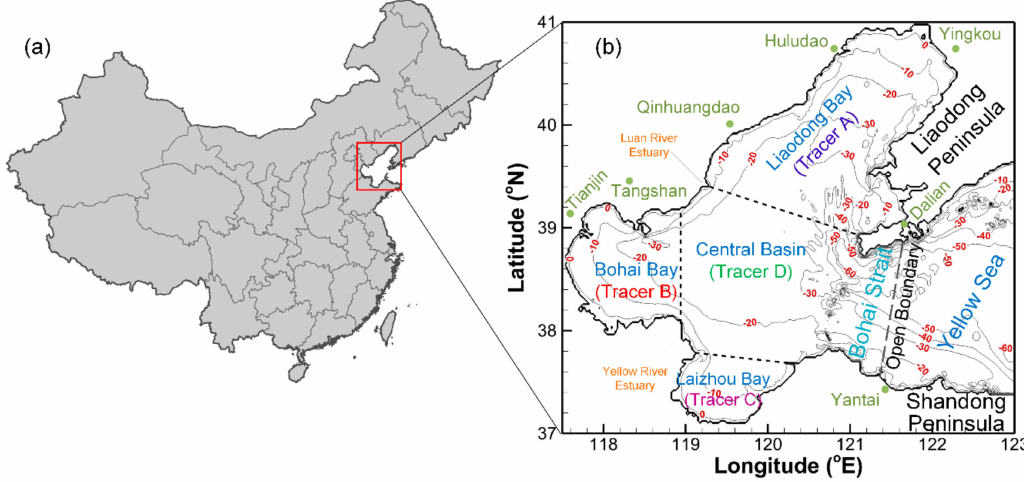
Figure 1. The location ( a ) and bathymetry ( b ) of the Bohai Sea and its